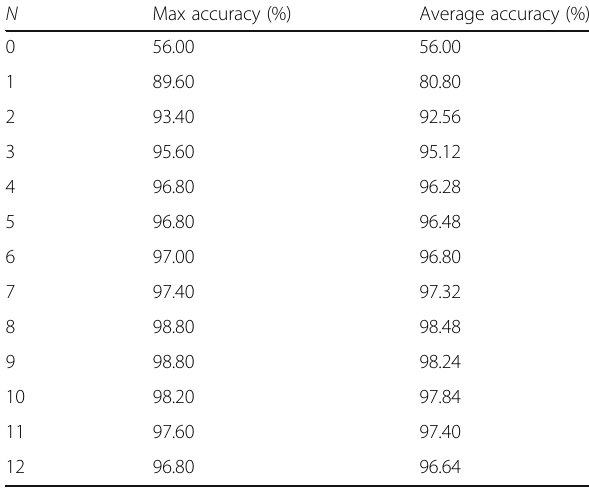
Table 6 Max and average accuracy for the three-class problem, for N = 0 – 12